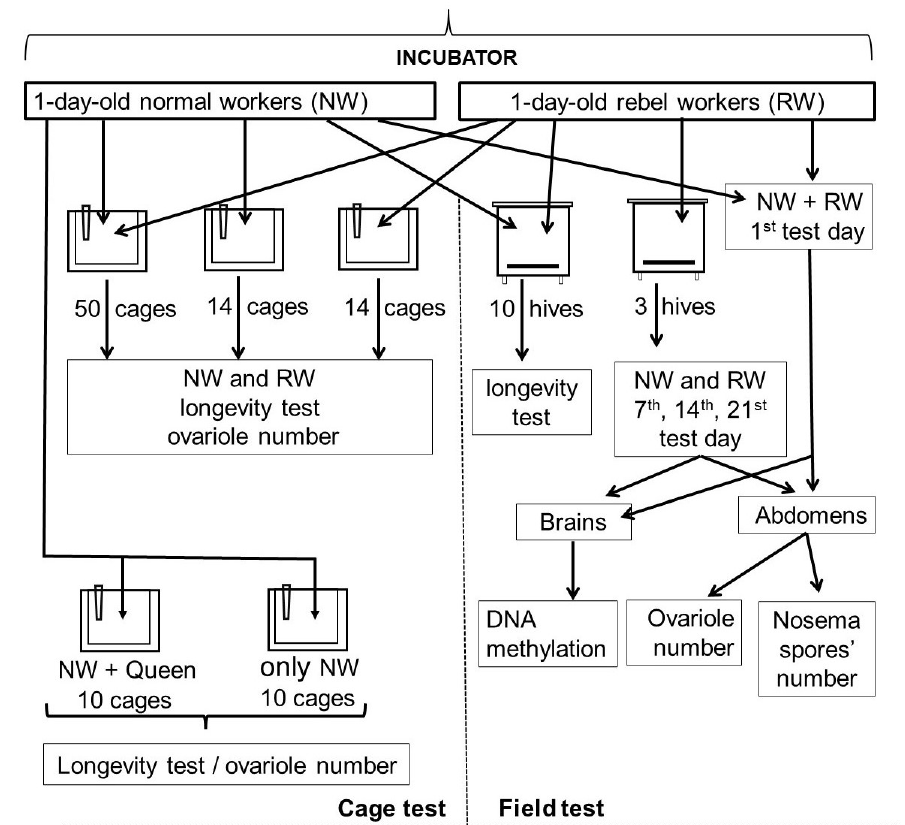
Figure 1. Schemes of the cage and field (in hives)